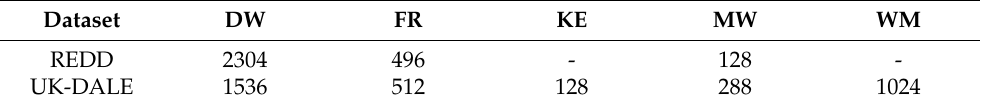
Table 1. Sequence length ( L ) for the LDwA